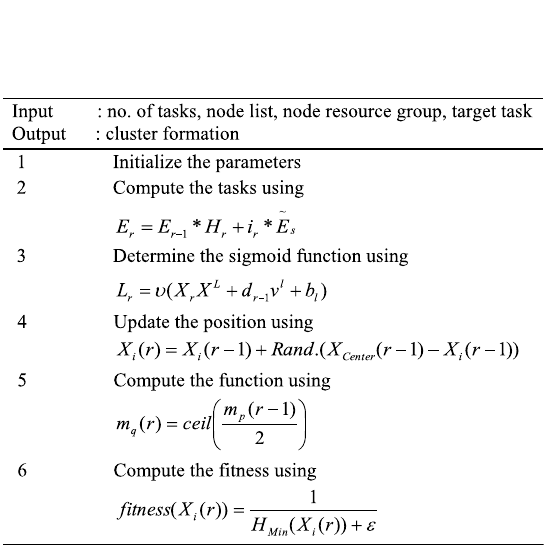
Algorithm 2 Task clustering using MPIO